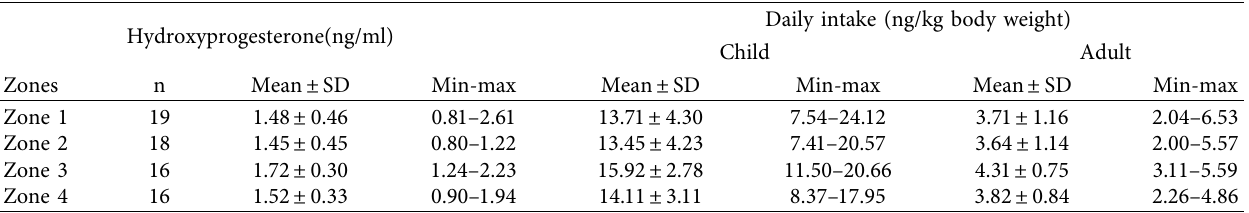
Table 5: Milk hydroxyprogesterone level and its daily intake in the different regions of Hamadan, Iran.